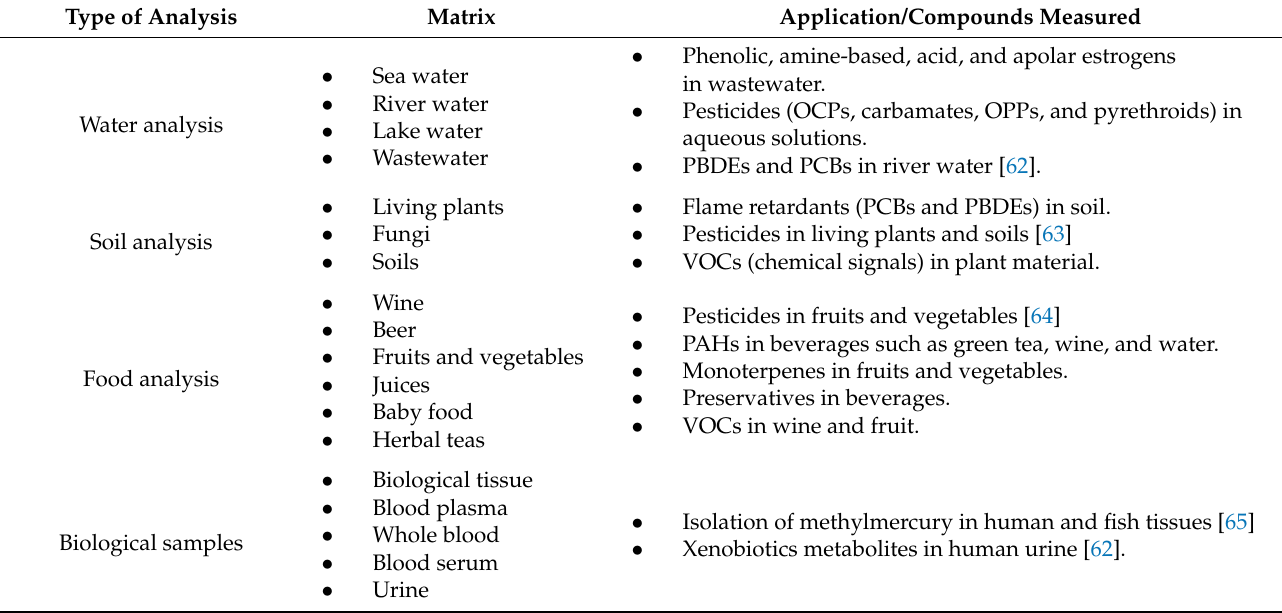
Figure 5. The main steps for the adsorption of the sample in SBSE can be performed in two different extraction modes: immersion ( 5a ) or headspace ( 5b ) modes. The extraction procedure is followed by thermal desorption if the separation is carried out by gas chromatography ( 5c ) or liquid desorption if the sample is analyzed by liquid chromatography or GC ( 5d ). Table 7. Information on main applications of SBSE.